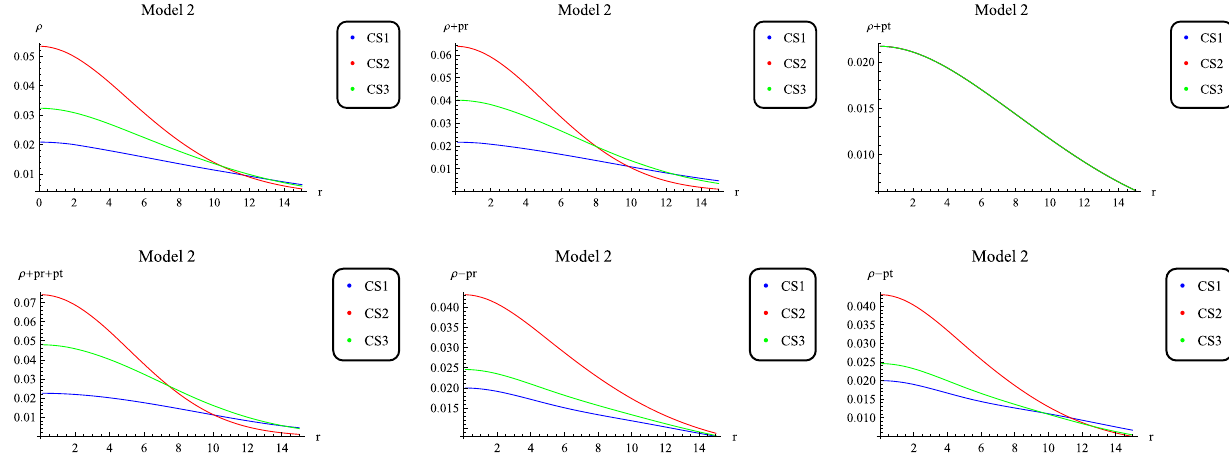
Fig. 8 Viability of energy conditions for three different strange stars with f ( R ) = R + β R ( e ( − R /